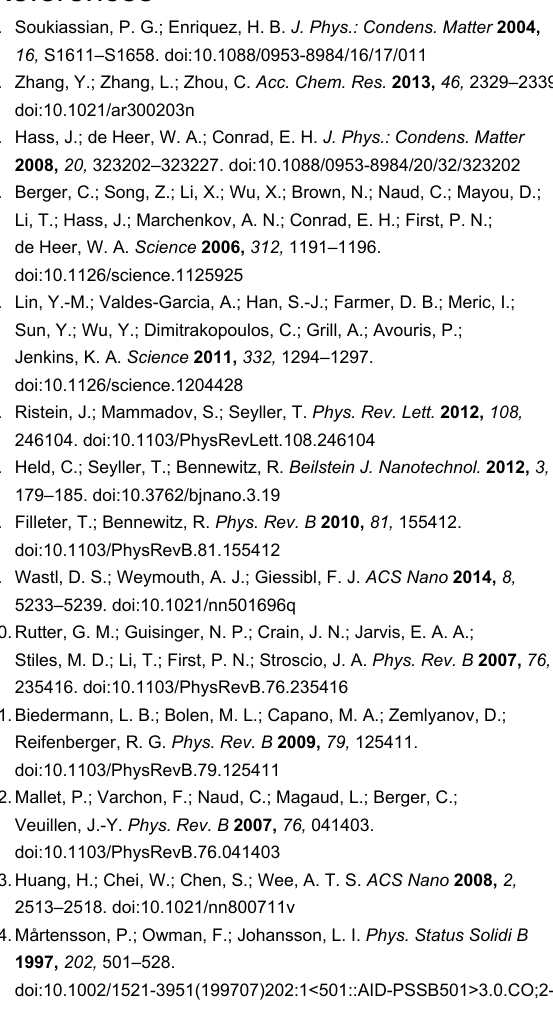
Ru(0001) and graphene/Ir(111) that are both claimed to be in the range of 100 pm (corresponding to 35 pm RMS)